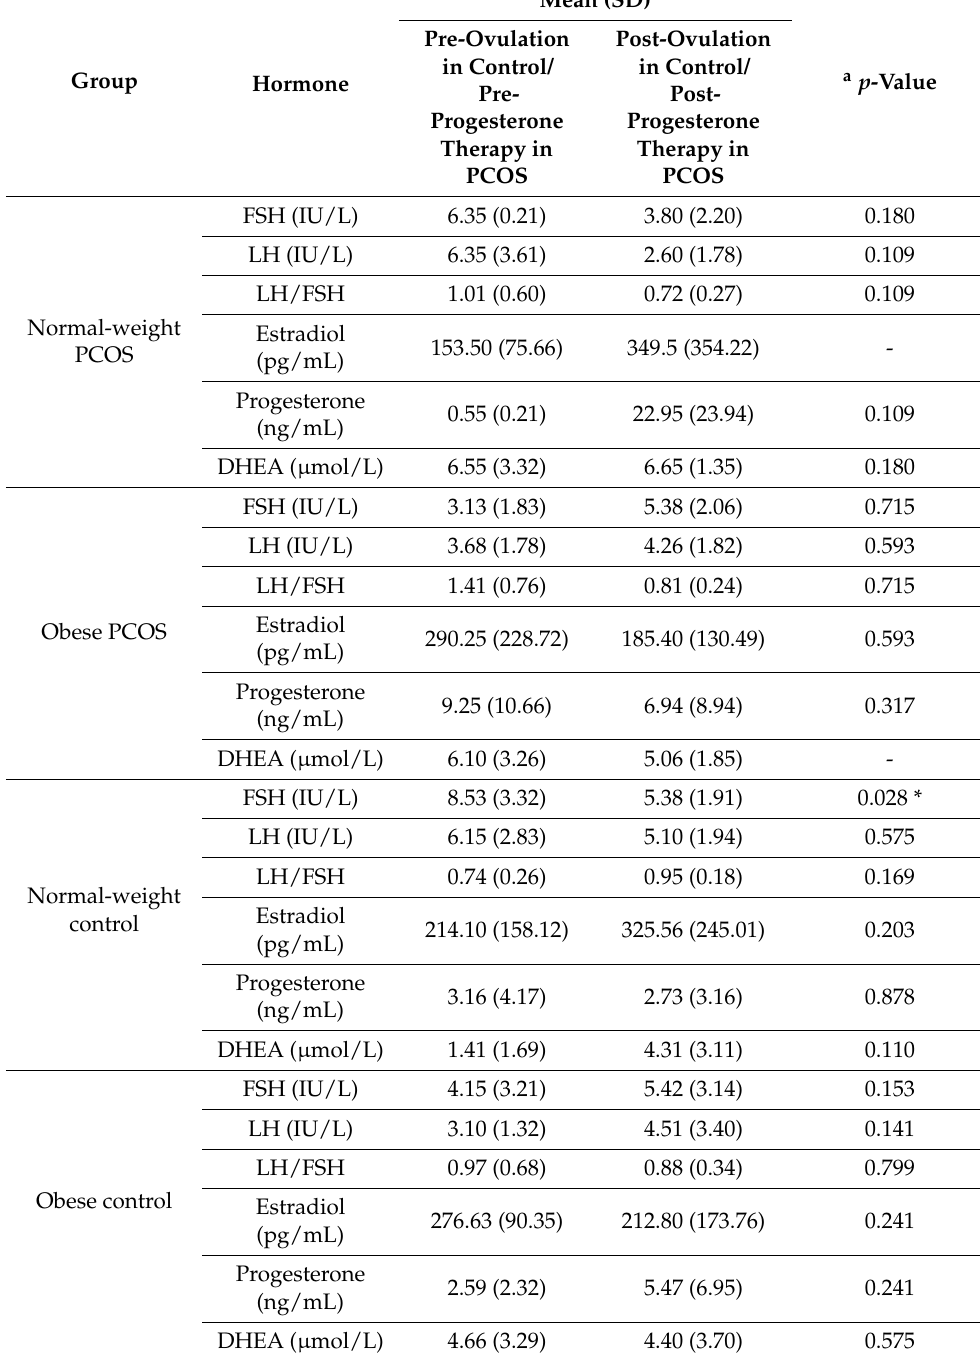
Table 2. Hormones level during pre- and post-ovulation or progesterone therapy according to the study